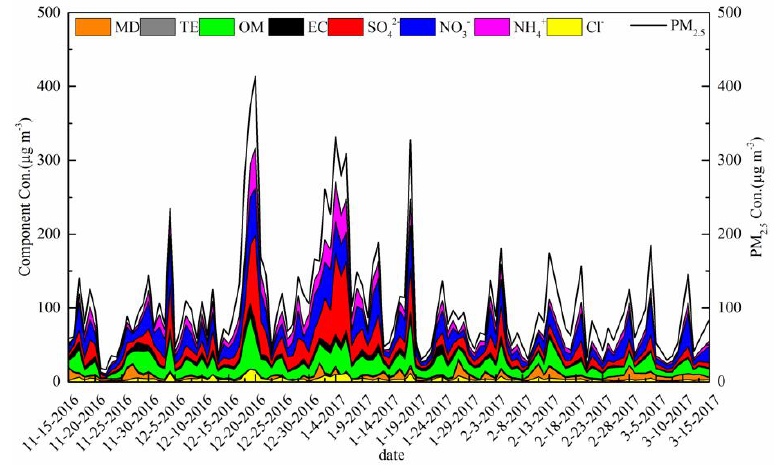
Figure 2. Time series of PM 2.5 and main chemical composition. Table 1. Average concentrations and chemical compositions of PM 2.5 during the sampling period. PM